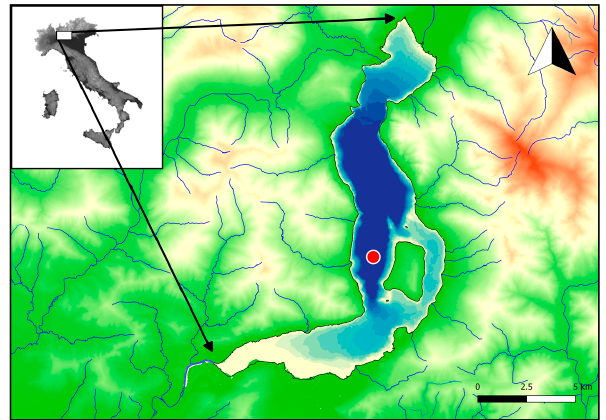
Figure 1. Location and bathymetry of Lake Iseo. The red dot indicates the position of the sampling point (modified [38]).